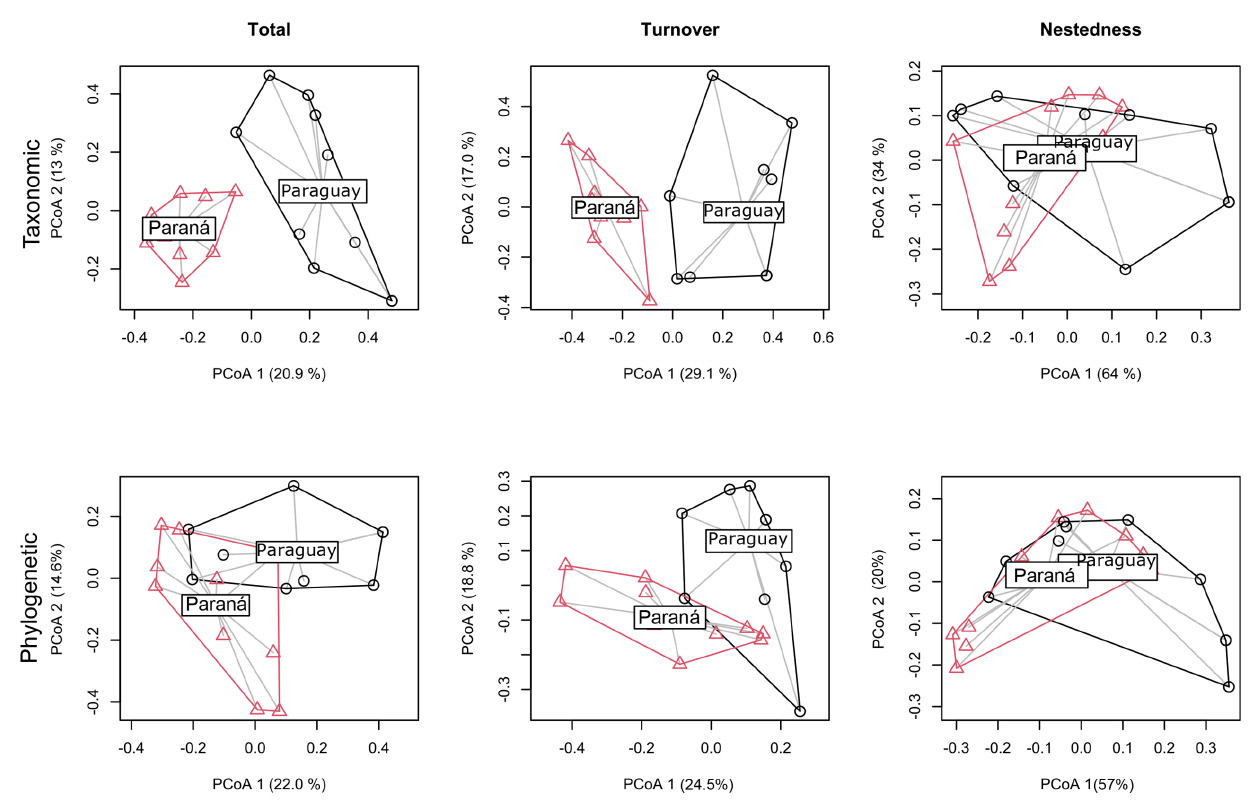
FIGURE 3 | Turnover and nestedness components of taxonomic and phylogenetic beta diversity in streams of the Paraná and Paraguai River basins. Clockwise from top left: total, turnover and nestedness components of taxonomic beta diversity; at the bottom, total, turnover and nestedness components of phylogenetic beta diversity. Filled circles correspond to Paraná streams and triangles to Paraguai